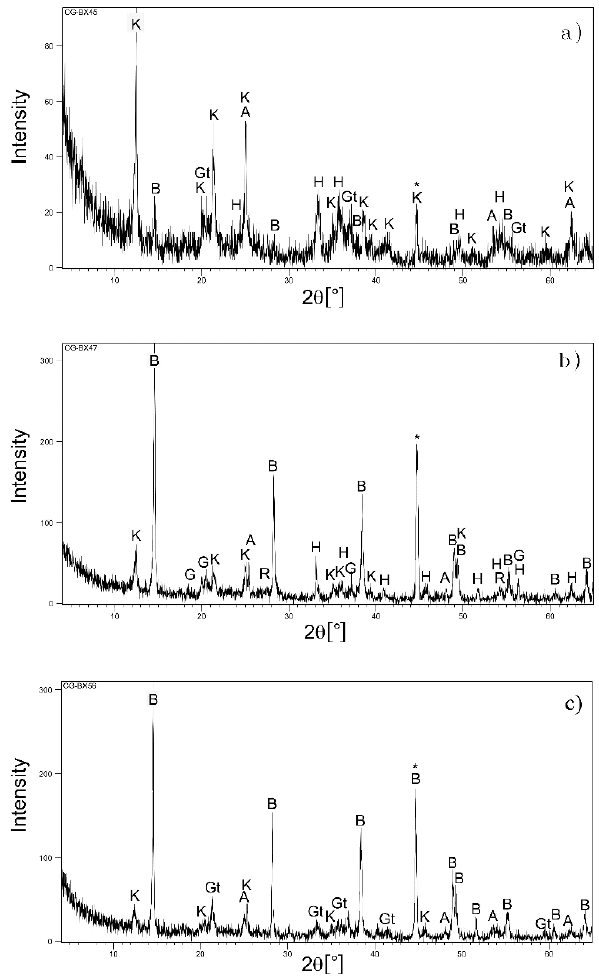
Figure 13. XRD patterns of typical analysed sample from bauxite deposits and occurrences: Bajov do ( a ), Bijele poljane ( b ) and Velika Gorana ( c ). (B—böhmite, G—gibbsite, A—anatase, H—hematite,